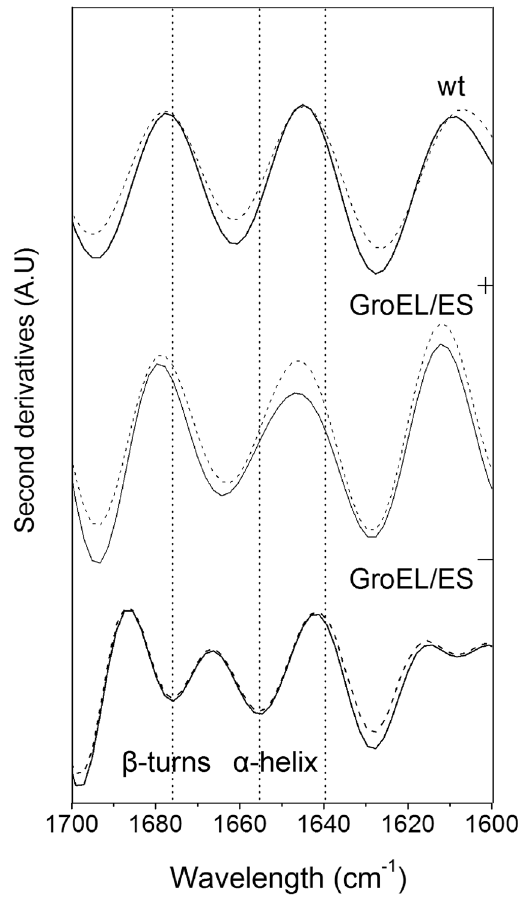
Figure 5. FT-IR analyses of IBs produced by the wt, GroEL/ES + and GroEL/ES − strains. Spectra of samples before (continuous) and after (dashed) in vivo refolding are shown. Bands in the wt and GroEL/ES + spectra at 1665 cm − 1 are attributable to β -turns, whereas the aggregate bands at 1630 cm − 1 and 1693 cm − 1 are characteristic of anti-parallel β -sheet intercellular interactions. Bands in the GroEL/ES − spectra at 1654 cm − 1 and 1678 cm − 1 were attributable to α -helices and β -turns, and the shoulder at 1640 cm − 1 indicated intramolecular β -sheet